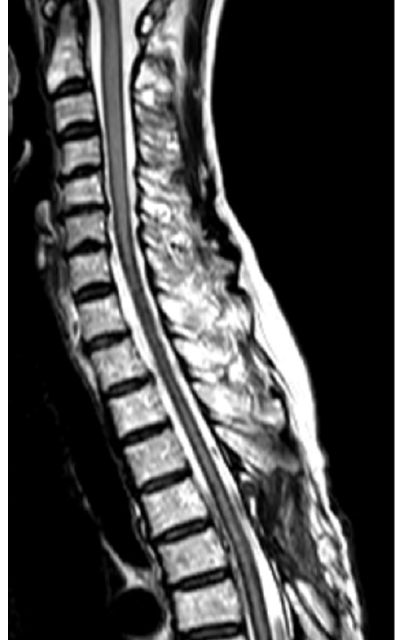
Figure 5. T2-weighted MRI of the cervical to upper thoracic spine taken three months after surgery confirms the resolution of the anterior epidural fluid